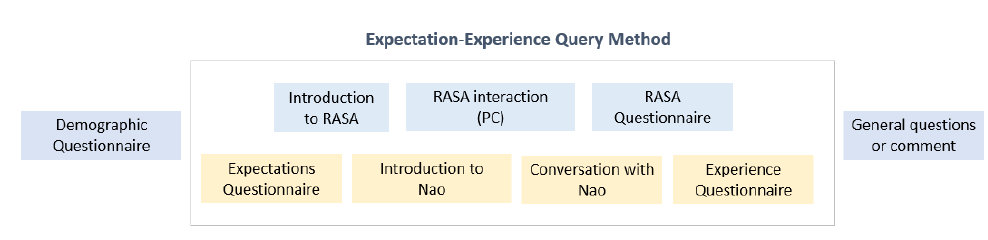
Figure 9. The experimental setup.